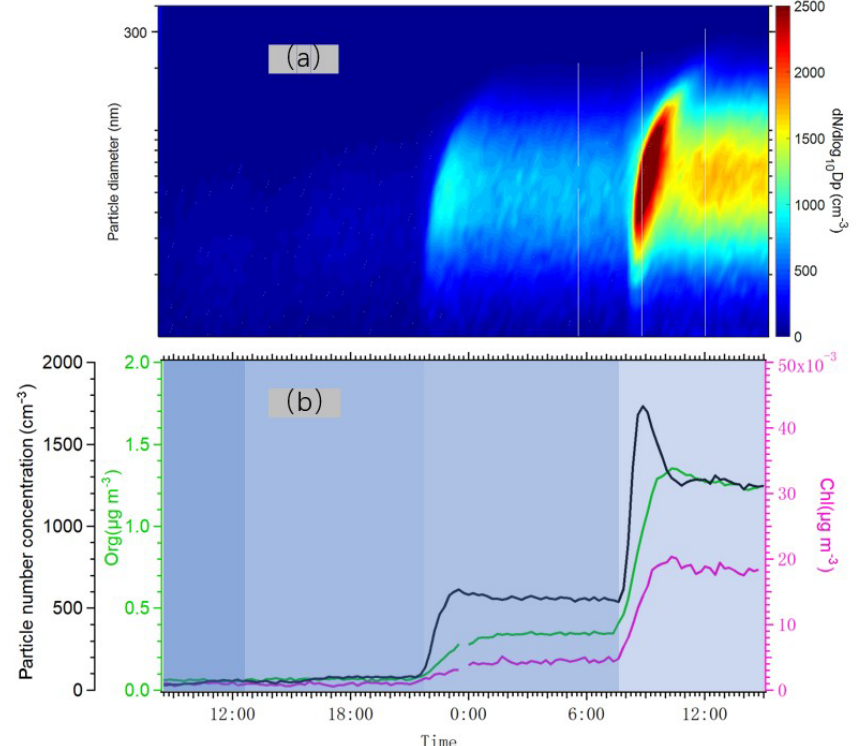
Figure 7. (a) Particle number size distribution measured by DMPS from 10 to 400nm, when the lights varied from one to two, four and seven. (b) Time series of total number concentration (black) measured by DMPS and organic aerosol concentration (green) and particulate chloride concentration (pink) measured by AMS.